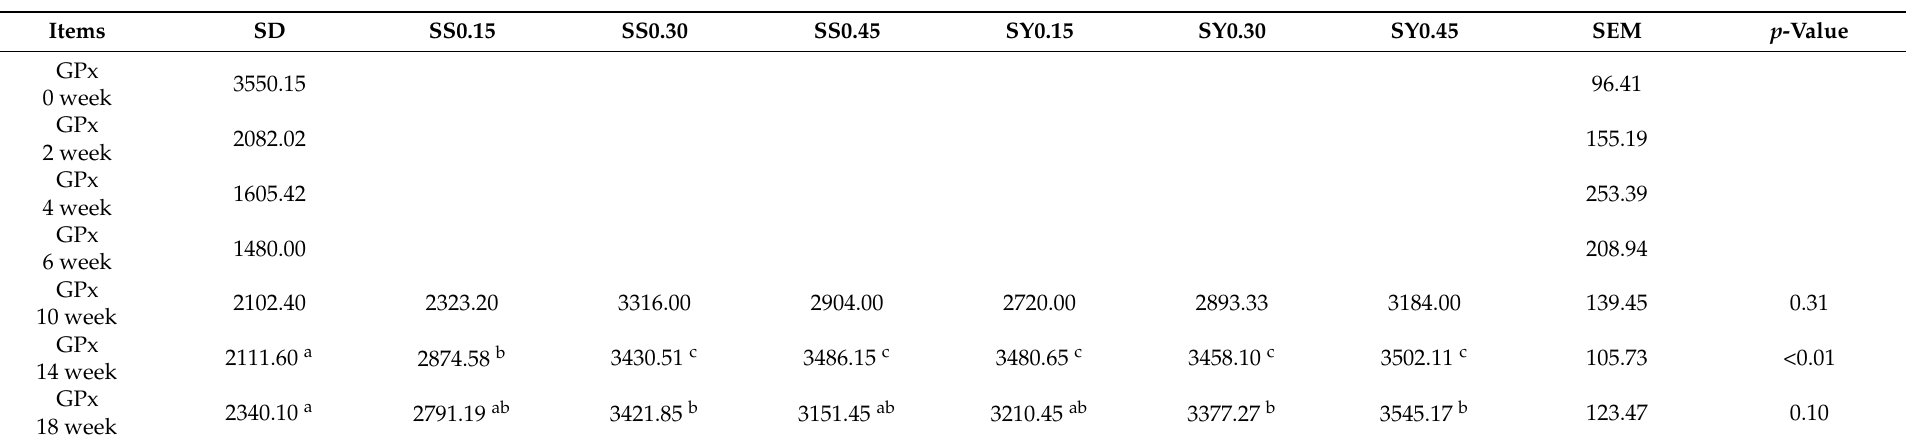
Table 4. Antioxidants capacity of plasma during whole experiment period (experimental weeks